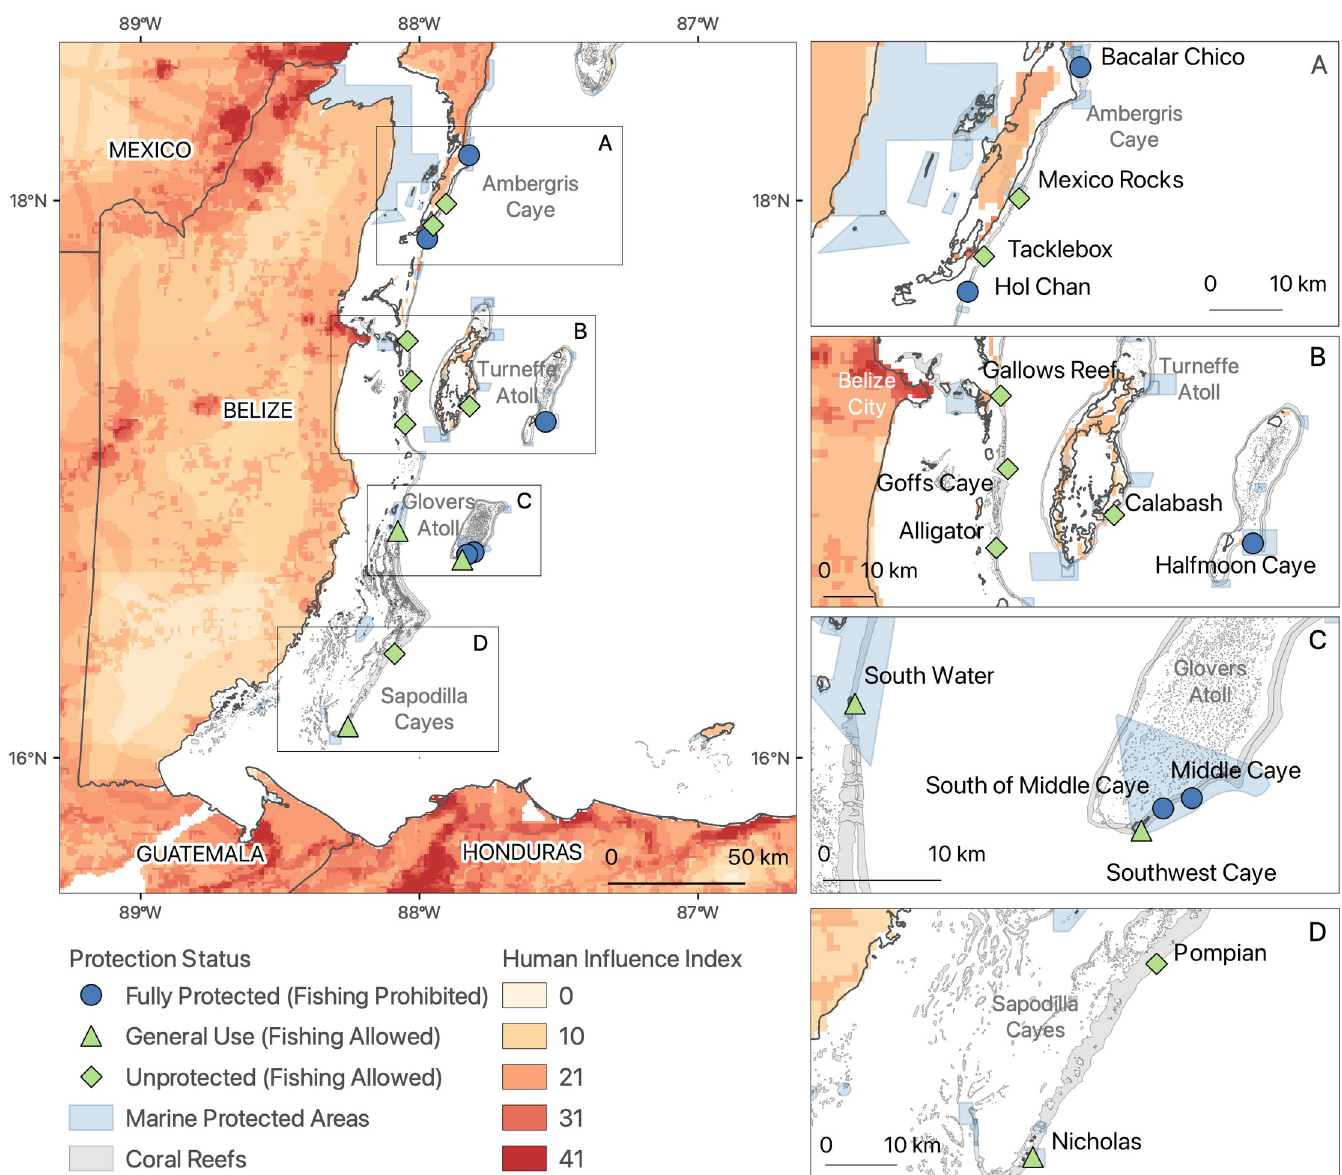
Fig 1. Study sites along the Belizean Barrier Reef. Sites are categorized by management level (fully protected, general use, unprotected) and prescribed protection status (fishing prohibited or allowed). Fishing is allowed in general use and unprotected sites (green) and is prohibited in fully protected sites (blue). Light blue polygons indicate the extent of MPAs. The Human Influence Index (HII), estimated at 1-km resolution for 1995–2004 across the landscape adjacent to study sites, is indicated in shades of light orange to red. GADM source: Database of Global Administrative Areas, Version 3.6 available at